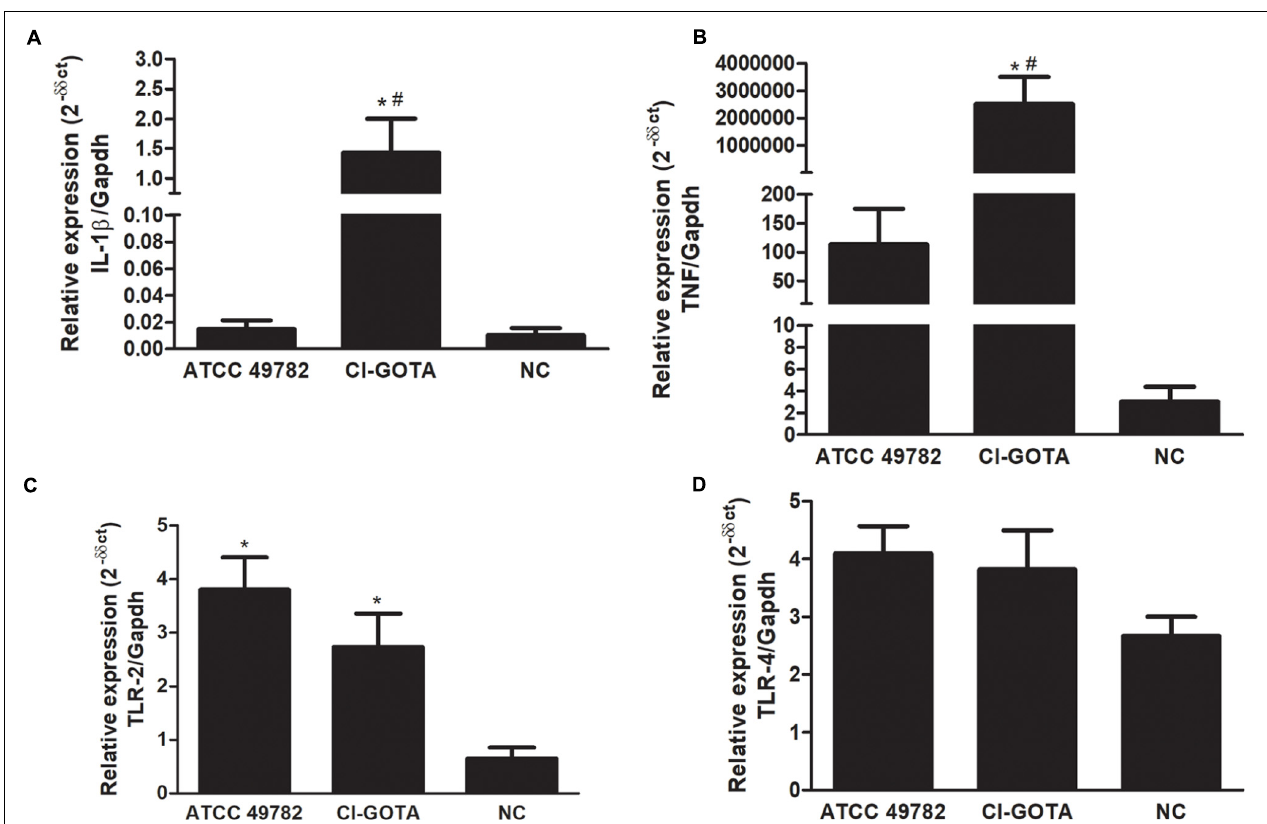
FIGURE 7 | Gene expression of cytokines and TLRs in bovine blastocysts infected for 24 h with ATCC 49782 and CI-GOTA strains. (A) Cytokine IL-1 β . (B) Cytokine TNF- α . (C) TLR 2. (D) TLR 4. PBS was used as negative control (CN). Statistically different groups are those presenting different symbols. Statistical significance ( p < 0.05) is represented by the symbols ( ∗ difference with the NC group, # difference among strains). Data are expressed as mean ± standard deviation ( n =